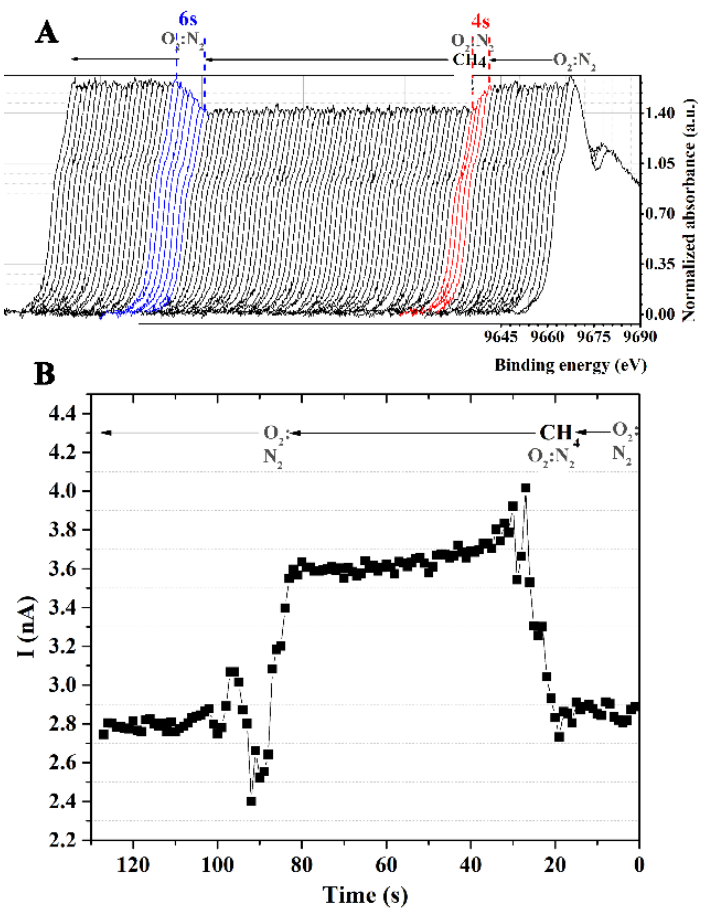
Figure 5. ( A ) The normalized Zn K-edge XANES of ZnO film under the CH 4 atmosphere and at 180 °C and ( B ) the current vs. time.